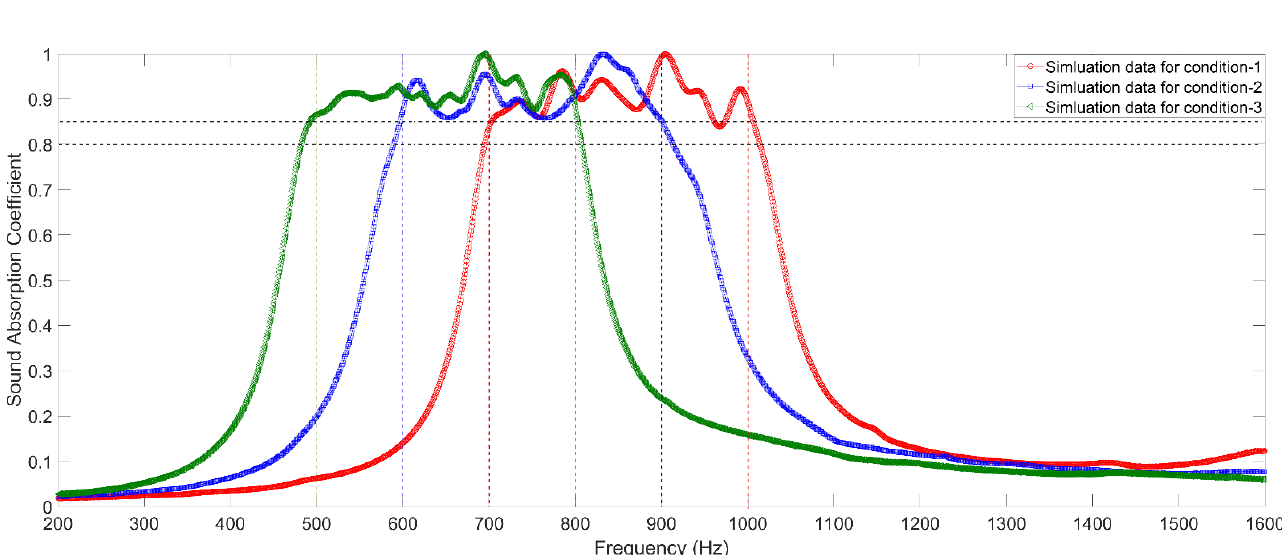
Figure 7. Distributions of theoretical sound absorption coefficients of the 3 optimized metamaterial cells obtained by the three − dimensional finite element model with the optimal parameters.